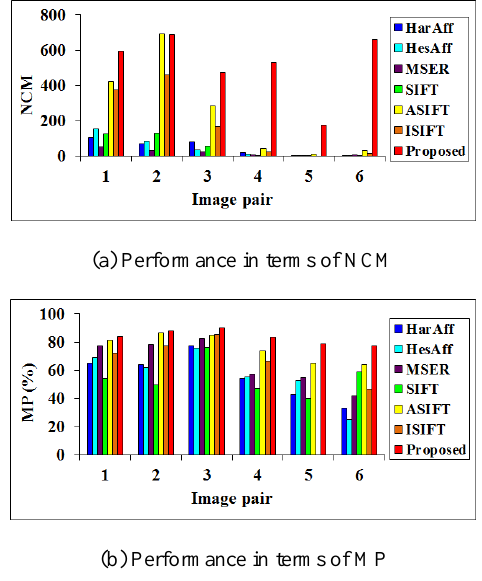
Figure 9. Quantitative comparisons